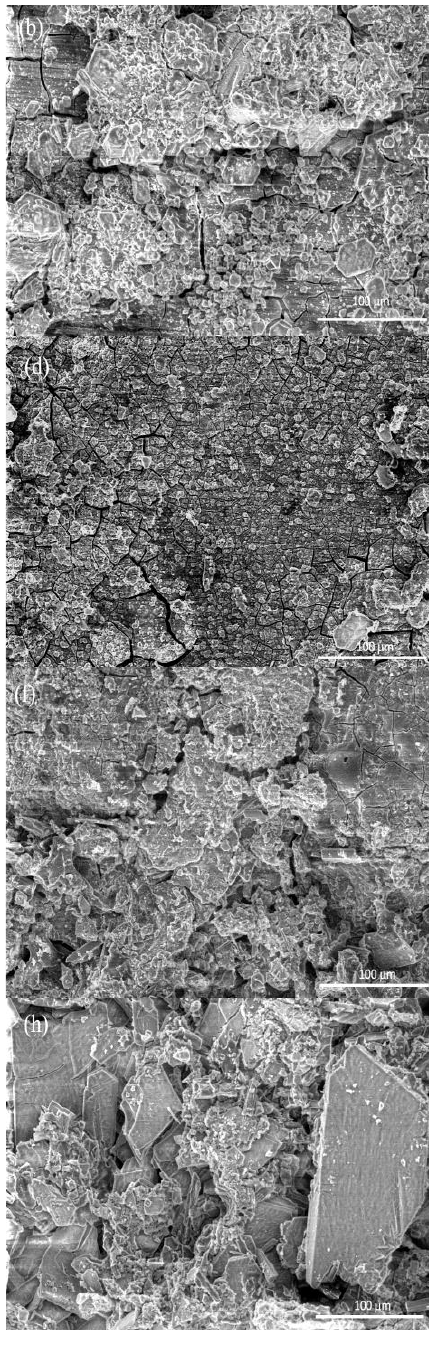
Figure 11. The surface morphologies of samples immersed in HBSS for 384 h: ( a ) and ( b ) ZX10 alloy, ( c ) and ( d ) ZX10-0.5ND, ( e ) and ( f ) ZX10-1ND, and ( g ) and ( h ) ZX10-2ND.